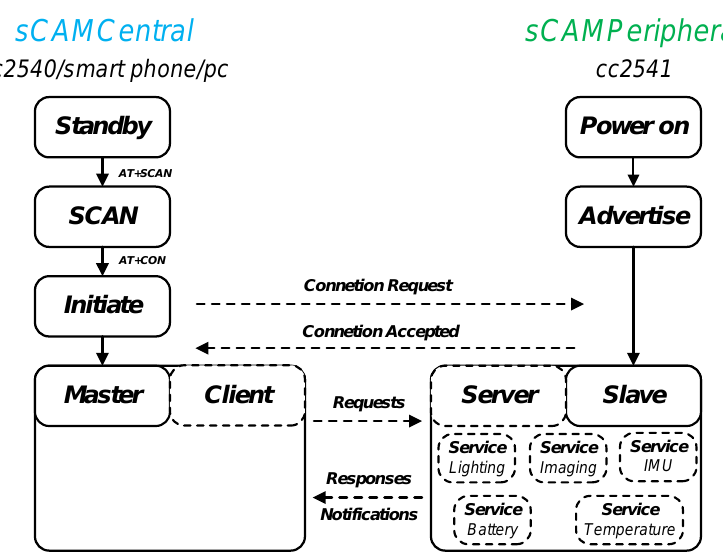
Figure 9. s-CAM BLE profile and application flow